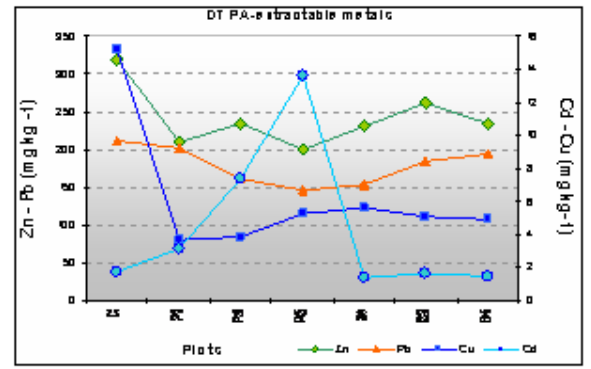
FIGURE 6. Concentration of DTPA-extractable metals found in the plots after 12 months of amendments addition. C: control; pig manure